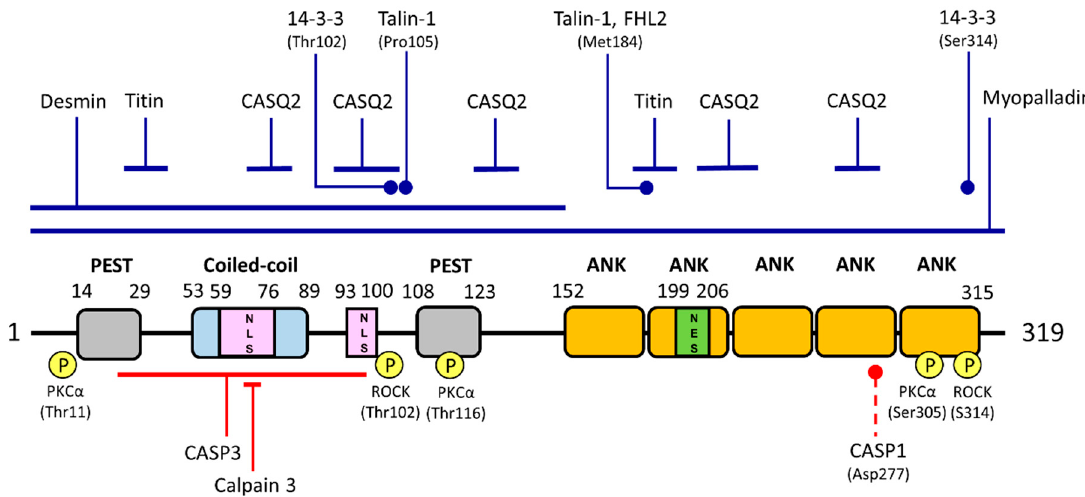
Figure 1. Schematic representation of human ankyrin repeat domain 1 (ANKRD1) structure, binding partners and phosphorylation and cleavage sites. The ANKRD1 protein has 319 amino acids consisting of a coiled-coil domain, two PEST-like regions, an ankyrin repeat domain consisting of five ankyrin repeats (ANK), two putative nuclear localization signals (NLSs) and one potential nuclear export signal (NES). ANKRD1 has two binding sites for titin and five binding sites for calsequestrin (CASQ2) which are indicated by blue solid lines. Regions or residues involved in interaction with myopalladin, desmin, talin-1, four-and-a-half LIM domains 2 (FHL2) and 14-3-3 proteins are also indicated accordingly. Experimentally verified phosphorylation sites (yellow-circled P) and the protein kinases (PKC α , protein kinase C; ROCK, Rho kinase) responsible are indicated. Regions harboring cleavage sites by caspase-3 (CASP3) and calpain 3 are indicated by solid red lines. Predicted caspase-1 (CASP1) cleavage site is marked by a dashed line. Diagram is not drawn to scale.